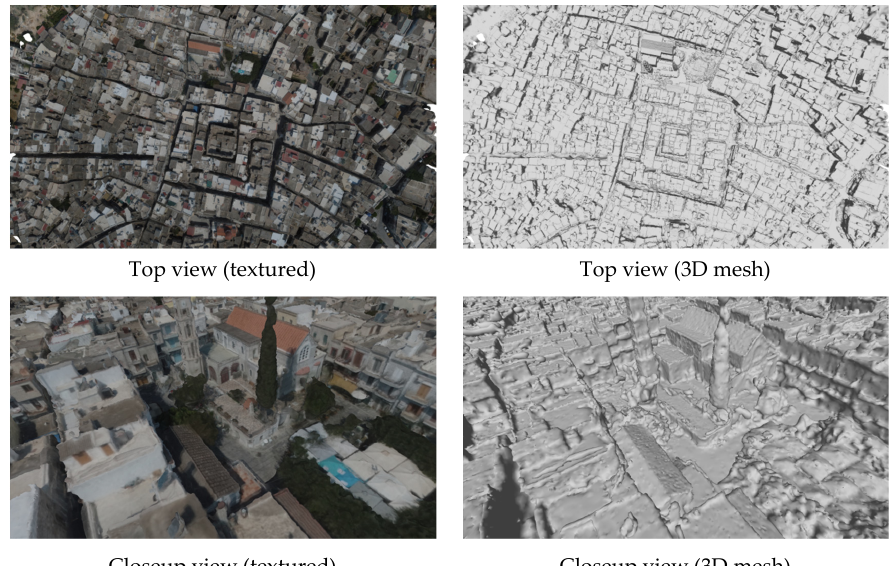
Figure 7. Village reconstruction.